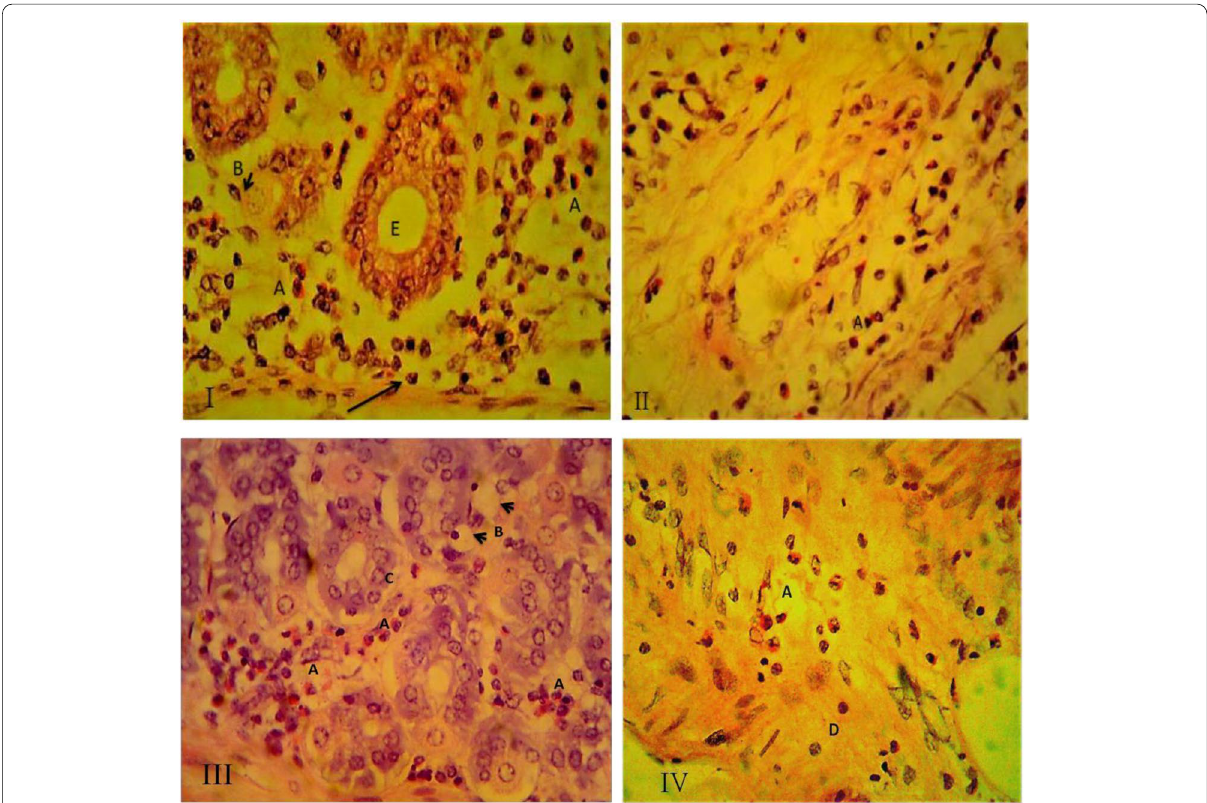
Fig. 10 Histopathological changes in the abomasal fundus of representative goat (I and II) and sheep (III and IV) infected with H. contortus: (A) numerous pink staining eosinophils in the lamina propria and the submucosa, (B) damaged/degenerating parietal cells, (C) intact chief cells, (D) neutrophil and lymphocyte (also arrow in I) in the submucosa, (E) body of abomasal gland; HE staining, 40x